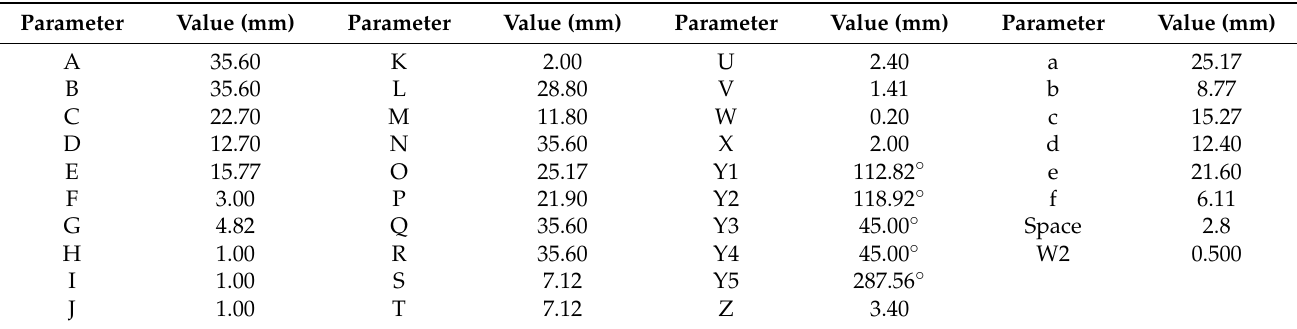
Figure 1. ( a ) AMC structure geometric design rear view, ( b ) AMC structure geometric design front view, ( c ) MTM unit cell geometric design. Table 1. All optimized parameters of the proposed prototype .